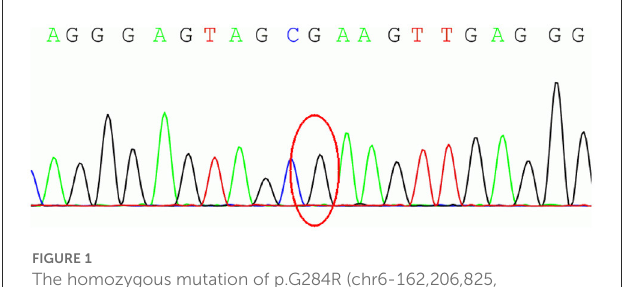
FIGURE1 The homozygous mutation of p.G284R (chr6-162,206,825, c.850G > C) in exon 7 of parkin RBR E3 ubiquitin protein ligase ( PRKN